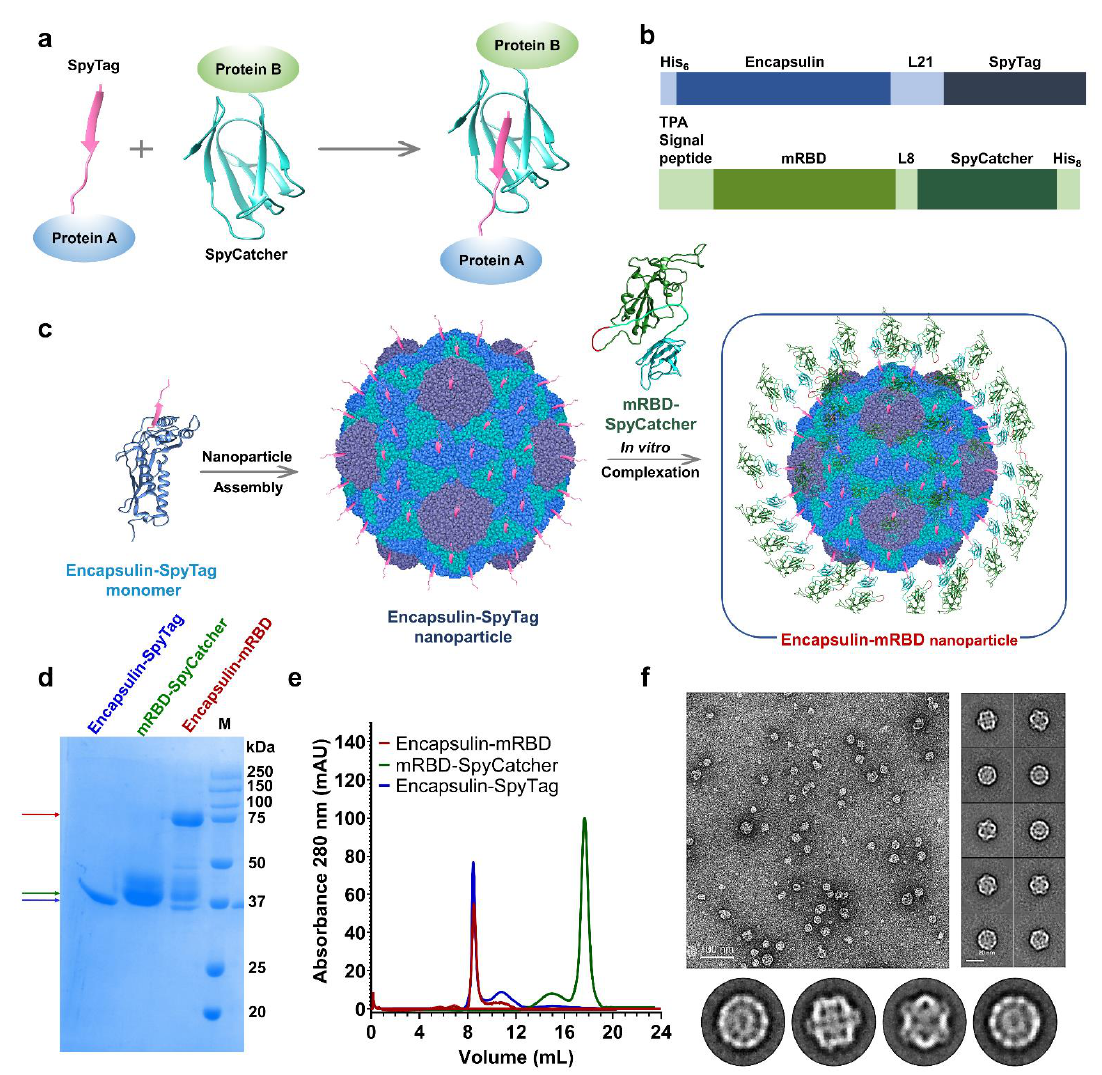
Figure 1. Design and biophysical characterization of Encapsulin-mRBD nanoparticles. ( a ), SpyTag– SpyCatcher chemistry. Shown here are two proteins, A and B, which are genetically linked to SpyTag and SpyCatcher, respectively. In vitro mixing of the two proteins results in spontaneous iso-peptide bond formation, leading to display of protein A on B. ( b ), Linear representation of the two conjugation partners, encapsulin – SpyTag and mRBD – SpyCatcher. Encapsulin (residues 1 – 287) (PDB id:4PT2) was genetically fused to a C terminal SpyTag through a 21-residue linker. A 6x- HisTag was attached at the N-terminus for Ni-NTA purification. mRBD (residues 332 – 532) was ge- netically linked to a C-terminal SpyCatcher via an 8-residue linker, as described previously [34]. An N-terminal TPA signal peptide and a C-terminal HisTag were attached for mammalian cell expres- sion and Ni-NTA purification, respectively. ( c ), Schematic of SpyTag – SpyCatcher mediated conju- gation of monomeric mRBD to Encapsulin nanoparticle. Genes in ( b , c ) are color coded for the ease of visualization as Encapsulin: blue, SpyTag: navy blue, monomeric mRBD: green, SpyCatcher: navy green. ( d ), Reducing SDS PAGE showing Encapsulin – mRBD conjugation. Lane 1 — Unconjugated Encapsulin – SpyTag (monomeric MW: 37 kDa), Lane 2 — Three-fold molar excess of mRBD –